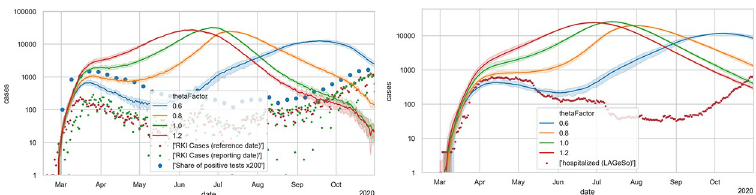
Fig 8. Simulations with reductions of activity participation as obtained from mobility data. LEFT: new cases; RIGHT: hospital occupancies.